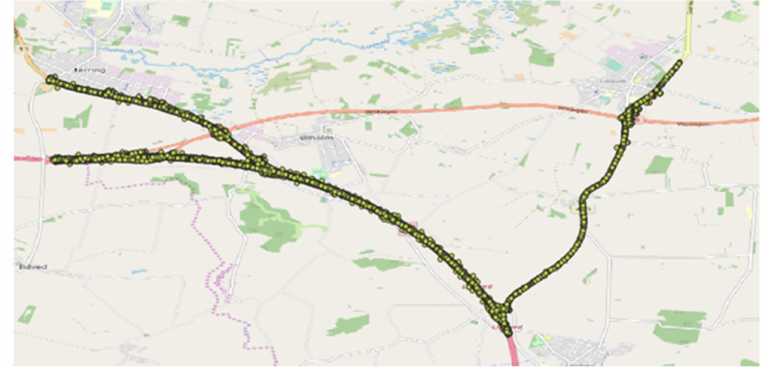
Figure 6. Zoom in on raw GPS-data from trucks, a snapshot from the developed system.